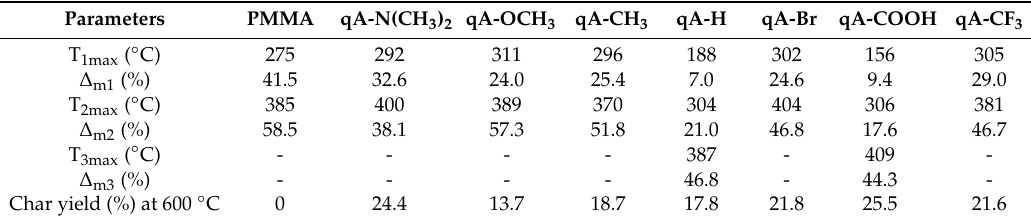
Table 2. Thermogravimetric parameters: temperature at maximal rate of the process (Tmax ( ◦ C)), weight loss ( ∆ m (%)) char residue at 600 ◦ C for pure poly(methyl methacrylate) (PMMA) and PMMA covalently bound with azo- moieties. The numbers accompanying temperatures and weight loss refer to the subsequent stages of